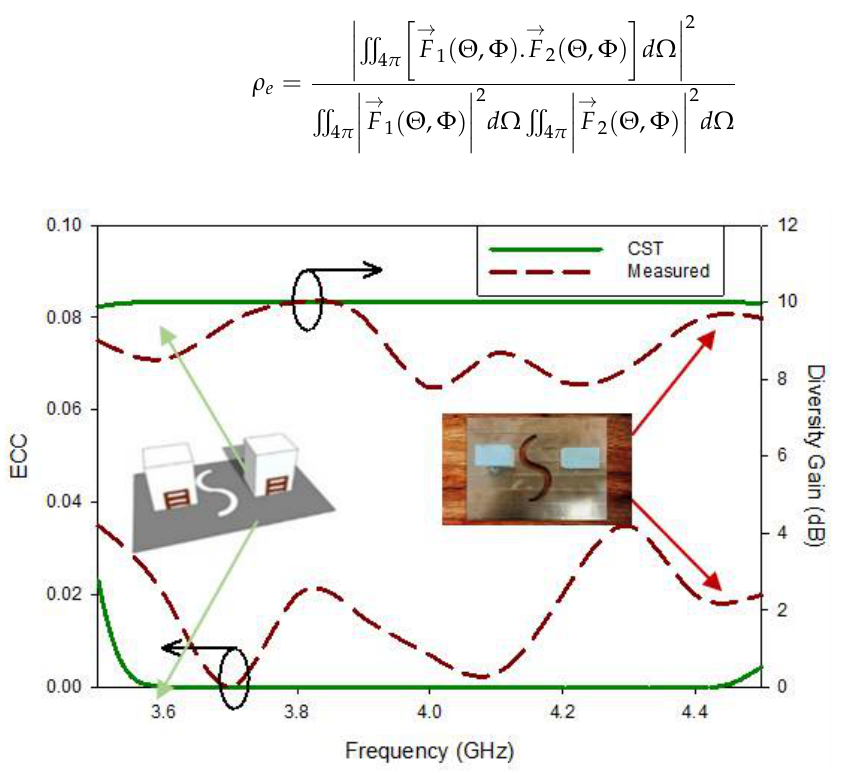
Figure 20. ECC and DG of the proposed MIMO antenna.